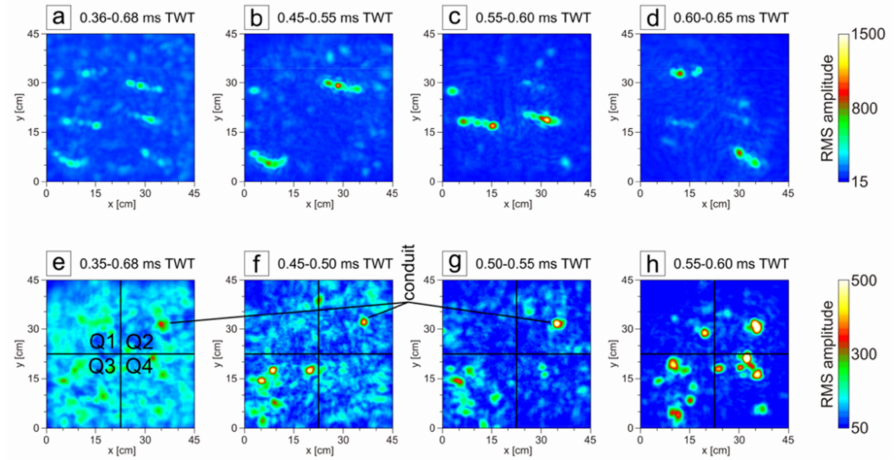
Figure 4. RMS amplitudes are calculated as volume attribute in different depths. ( a – d ) The data cube (Figure 5) includes six fruit gummy worms at different depths. The section including the entire sedi- ment layer ( a ) shows the location and orientation of all six objects and the reflection of the sediment surface. Shorter time sections ( b – d ) allow for a more detailed display of only the two fruit gummy worms in the respective depth. ( e – h ) The data cube (see also Figure 3) is characterized by disturbances of variable extent in the sediment layer. The RMS amplitude, including the entire sediment column ( e ) shows little differences between the four quadrants. Shorter sections of increasing depth ( f – h ) provide a different pattern in the quadrants. Continuously highest amplitudes appear in the lower- left quadrant (Q3), where disturbances affect the entire sediment column. The constant lateral patch of high amplitudes in the upper right quadrant (Q2), marked as conduit, corresponds with the intersection point of the spatula